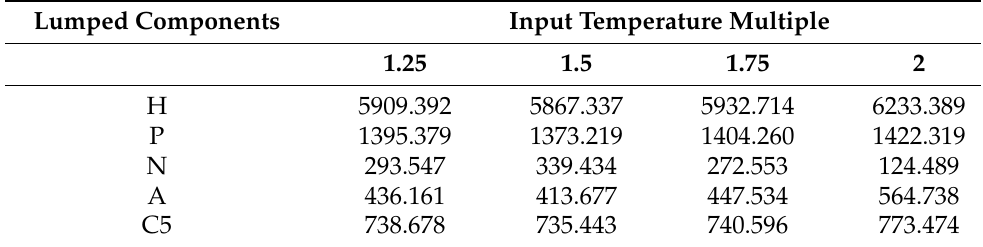
Table 4. The influence of reactor input temperature on each lumped component.